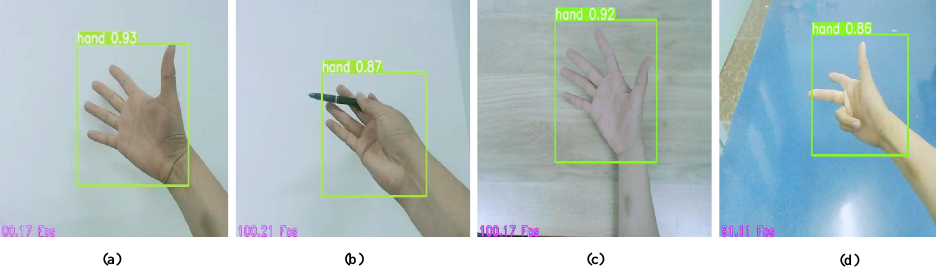
Figure 9. Sample test of the YOLOv3 hand detection model. ( a – d ) show the test effect of different gestures and different